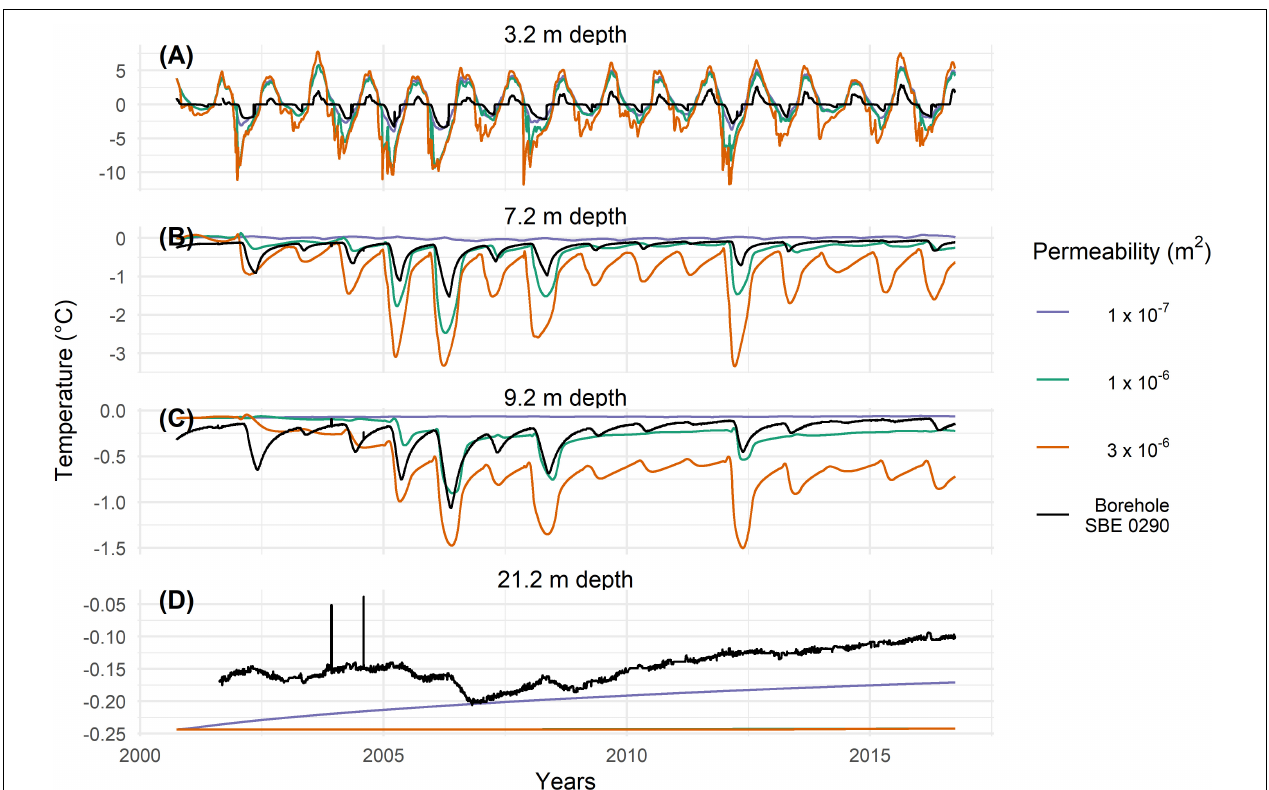
FIGURE 4 | Modeled temperatures at SBE for different permeability at different depths of 3.2 m (A) , 7.2 m (B) , 9.2 m (C) , and 21.2 m (D) in a virtual borehole in the middle of the model domain (see Figure 1 ). Measured temperatures in the borehole are shown in black for the SBE0290 borehole. In panel (D) the orange line covers the green